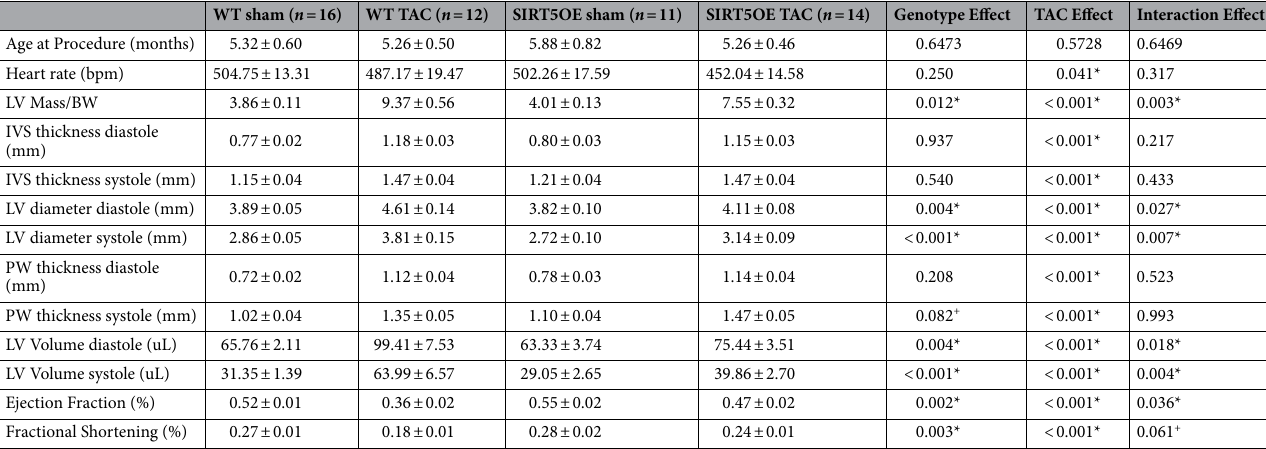
Table 1. Echocardiogram measurements 4 weeks after surgery in WT, SIRT5 sham and TAC mice. Values listed as mean ± standard error of the mean (SEM). Statistical significance was determined using two-way ANOVA. Significance markers: (*) p < 0.05, ( +) p < 0.1